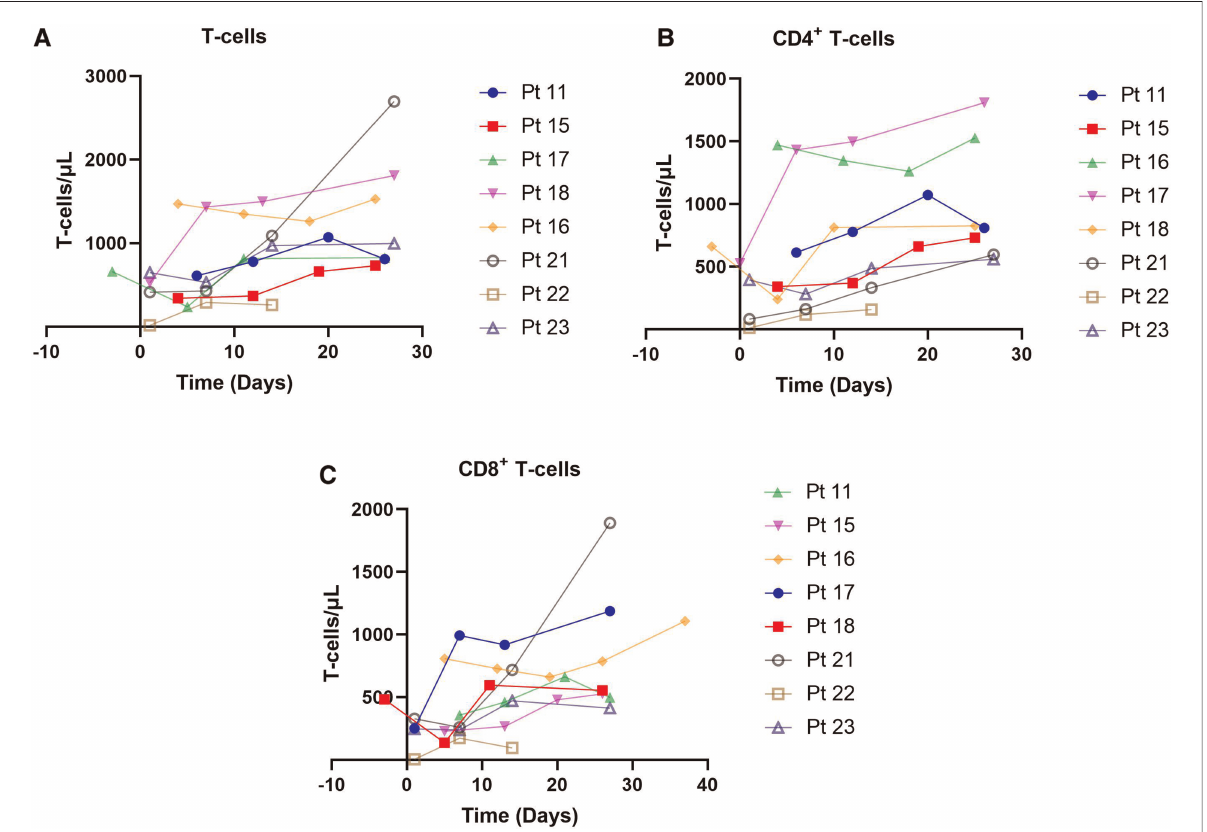
FIGURE 3 T -cells observed in 8 patients. ( A ) CD8+T-cells , chemotherapy-eligible, 7-month follow-up. ( B ) CD8+T-cells , chemotherapy-eligible, 2-month follow-up. ( C ) CD3+T-cells , chemotherapy-eligible, with 1-month